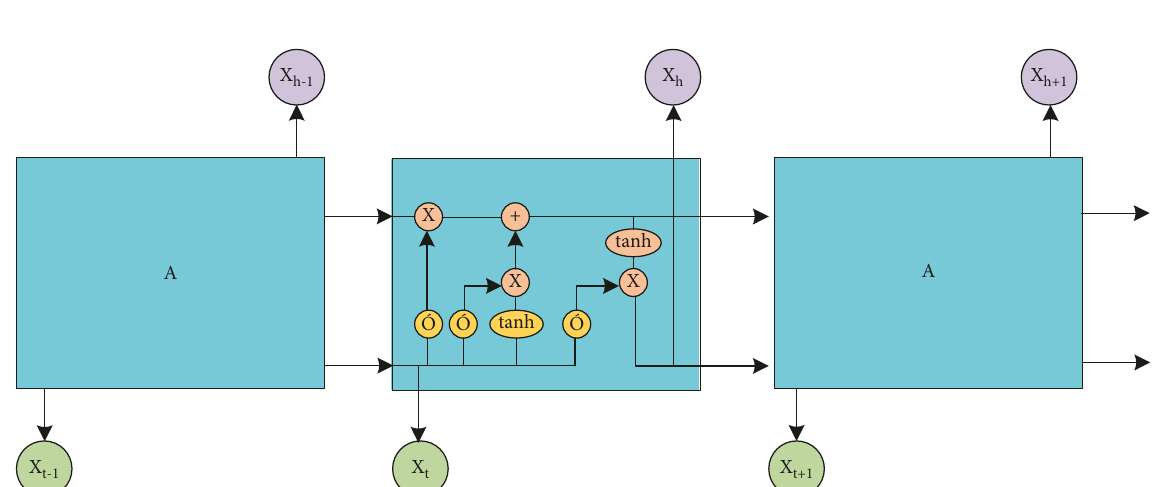
Figure 2: Diagram of LSTM